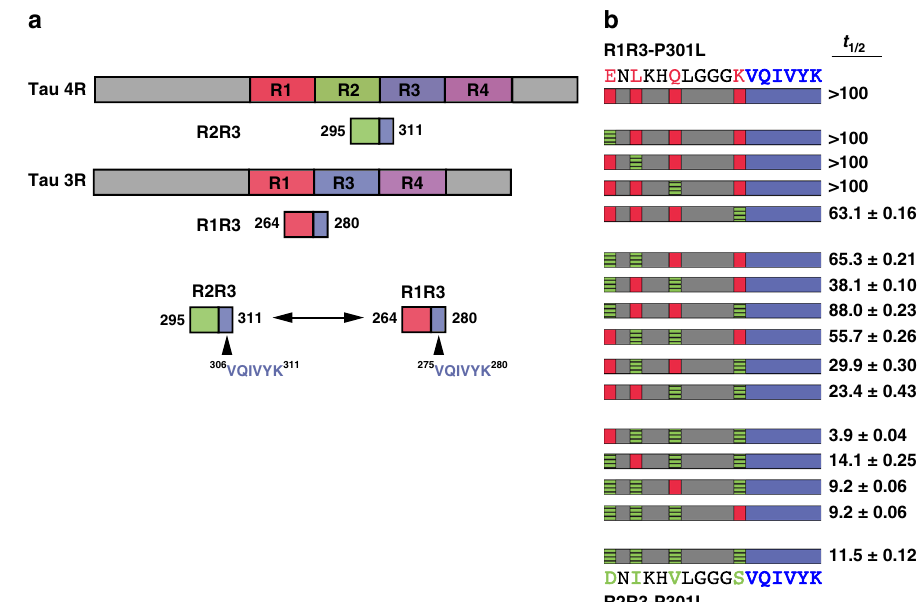
Fig. 6 Alternative splicing modulates aggregation propensity. a Cartoon schematic for tau 4R and 3R splice isoforms illustrate the difference in primary amino-acid sequence leading into the amyloidogenic 306 VQIVYK 311 motif. b A full combinatorial panel of R2R3-P301L and R1R3-P301L chimeras were aggregated in vitro. 306 VQIVYK 311 is shown in blue, amino acids common between the splice isoforms are shown in gray, amino acids unique to an R3 isoform are colored red, amino acids unique to an R4 isoform are colored green. The aggregation kinetics, represented as t 1/2 in hours with 95% CI, are listed in the right-side column alongside its respective